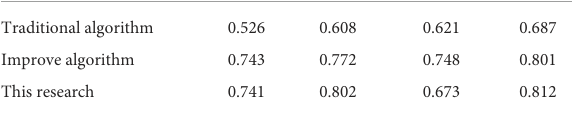
TABLE 2 Investigation of the content of business English translation by the clustering